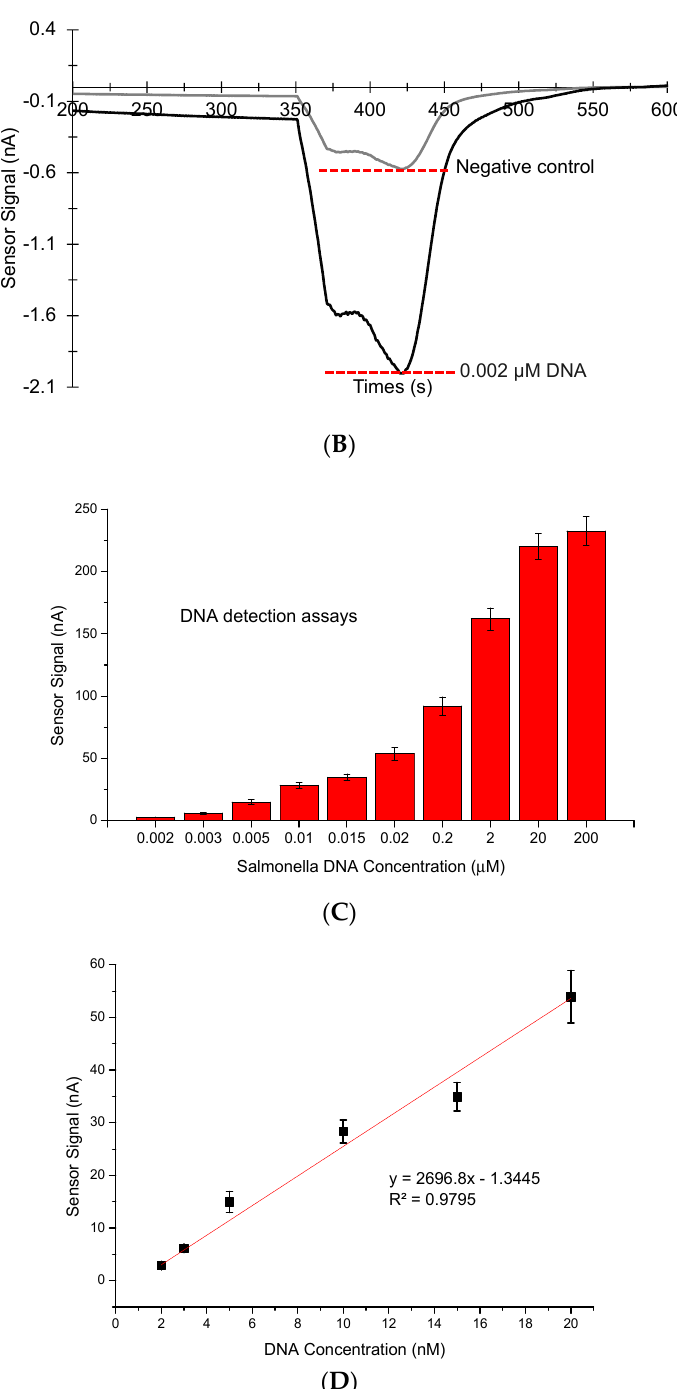
Figure 8. Concentration-dependent real-time sensorgram of the DNA assay ( A ). Real-time sensorgram showing signal difference between the lowest DNA concentration and negative control ( B ). The detection of Salmonella DNA in a concentration range of 0.002–200 µM along with standard deviations on the data (n = 6) ( C ). The linear calibration curve of DNA assays with a correlation coefficient of 0.9795 ( D ).